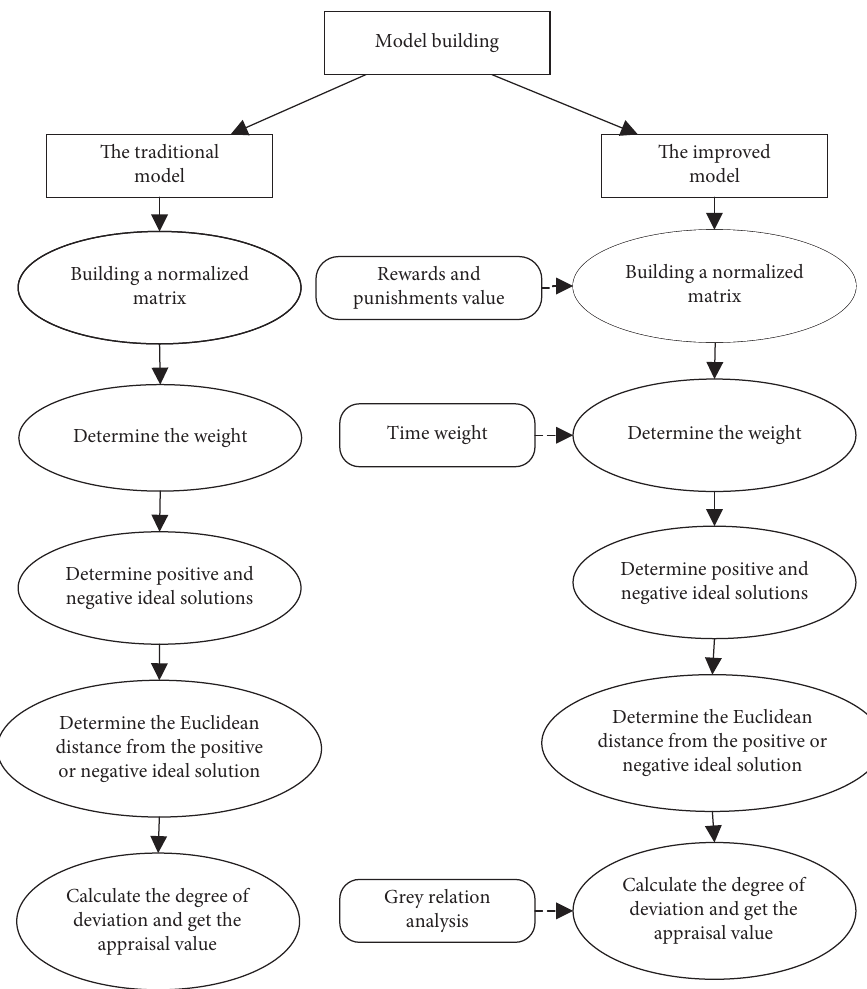
Figure 1: Flowchart of the traditional model and improved